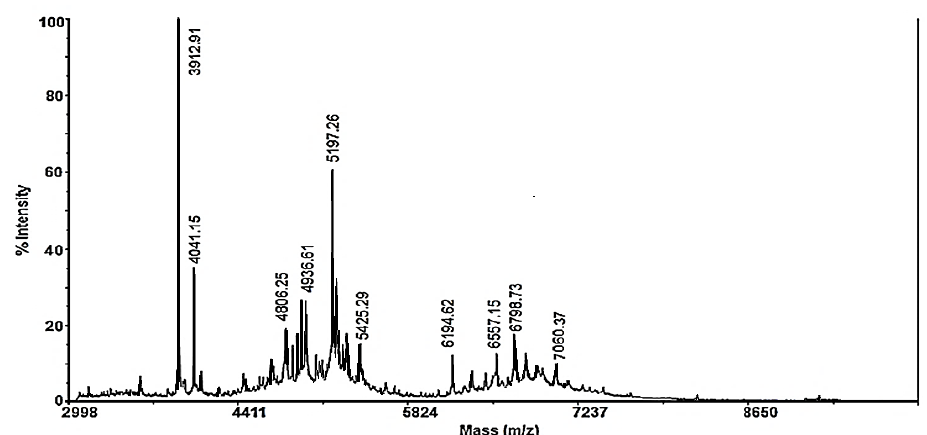
Figure 3. MALDI-MS spectrum recorded in the region of 3000–10000 m/z of the fraction with MW < 10 kDa. Standard peptide solution was used to calibrate the mass scale of the Autoflex™ III